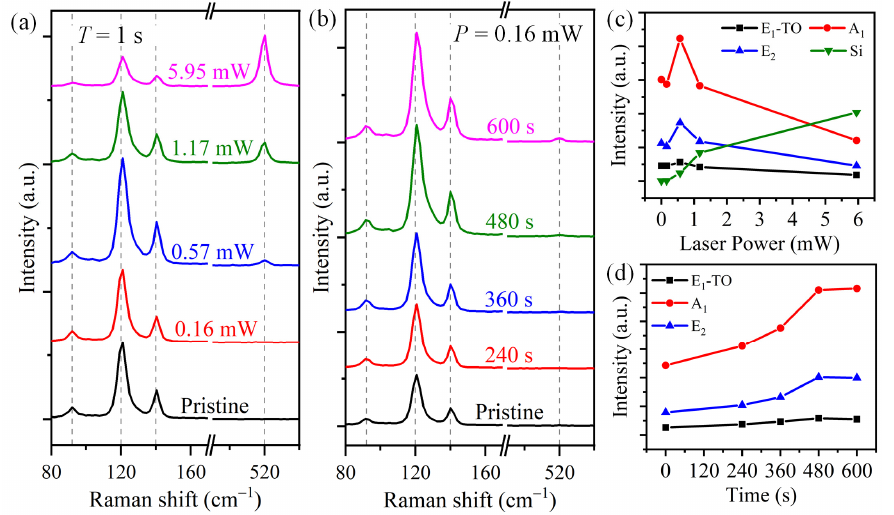
Figure 3. Changes of Raman spectra in Te flakes irradiated by laser. Raman spectra of Te flakes under different power ( a ) and irradiation time ( b ) and corresponding fitting intensities of peaks ( c ) and ( d ), respectively.